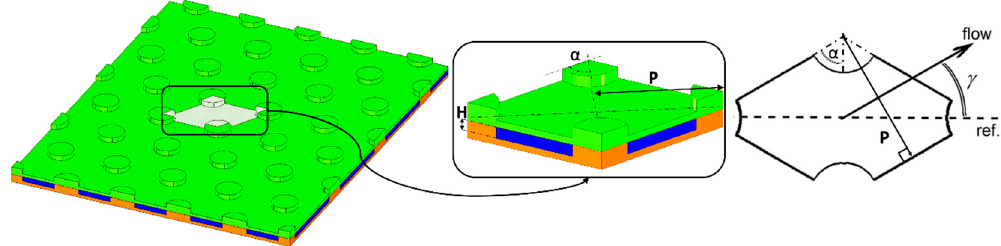
Figure 1. Round pillar (RP) profiled membranes: The repetitive unit (periodic cell) of a stack is highlighted on the left and is shown enlarged in the central inset. The geometric parameters H (channel thickness), P (pitch), α (intrinsic angle), and γ (flow attack angle) are indicated.